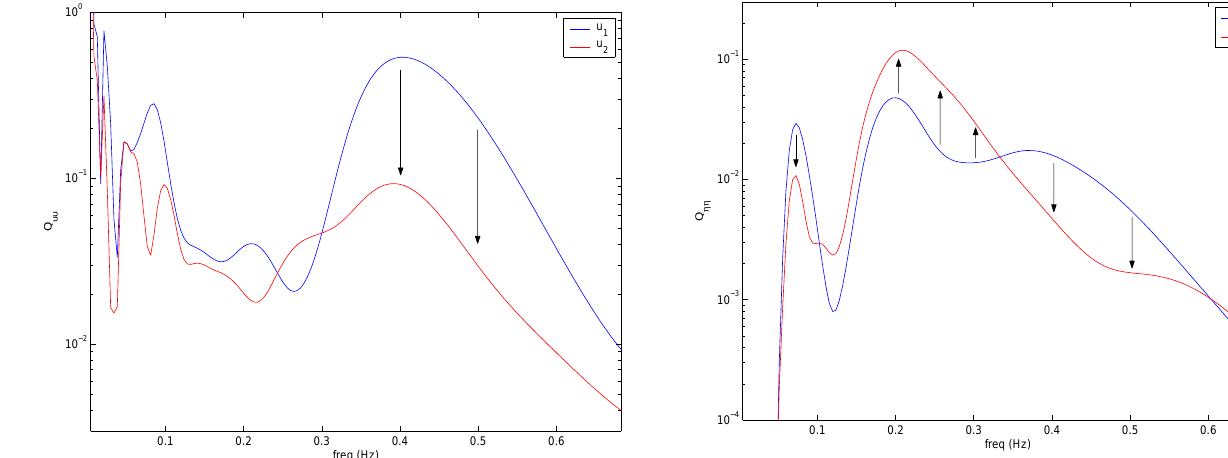
Fig. 4. Wavelet power spectra of the wind fluctuations in stages I and II; arrows highlight the changes of the energy level in major frequency components.